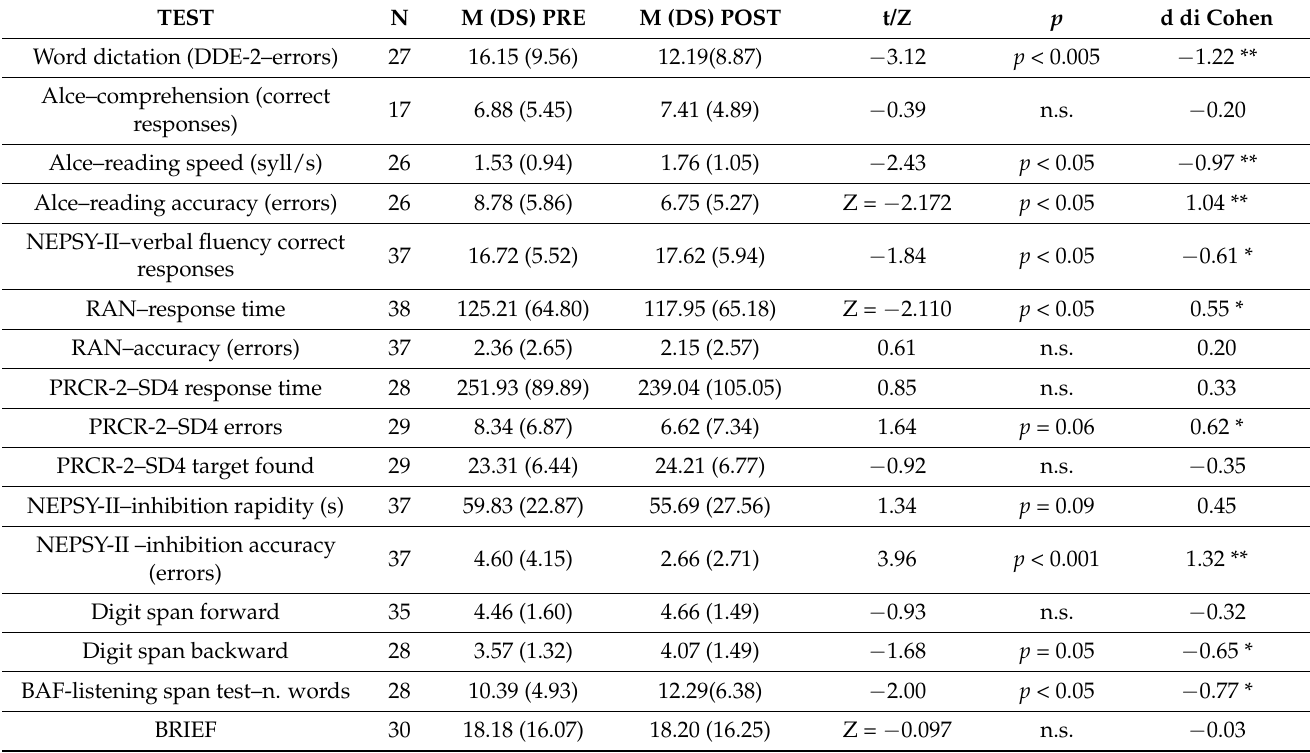
Table 3. Descriptive statistics, Student’s t -test or Wilcox Z, significance, and Cohen’s d for protocol measures at T0 and